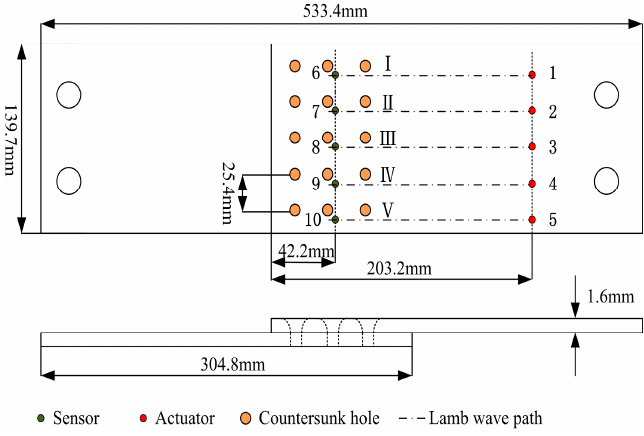
Figure 16. The geometry of the lap joint component and the sensor layout.